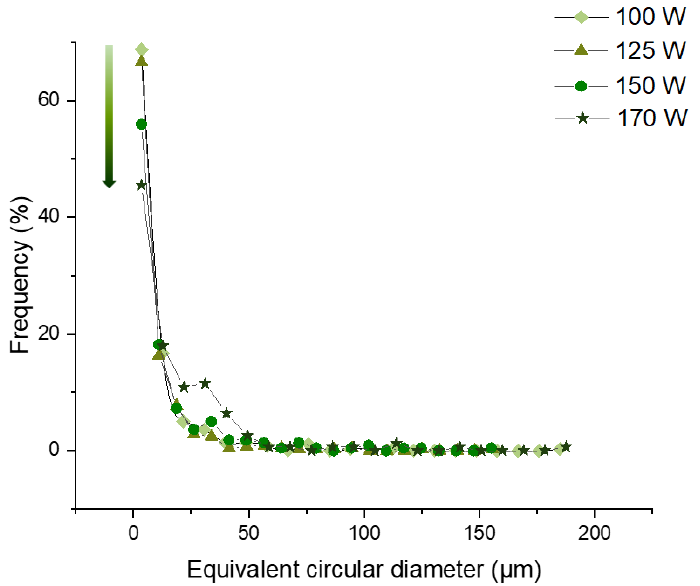
Figure 7. Grain size distribution as a function of power value.